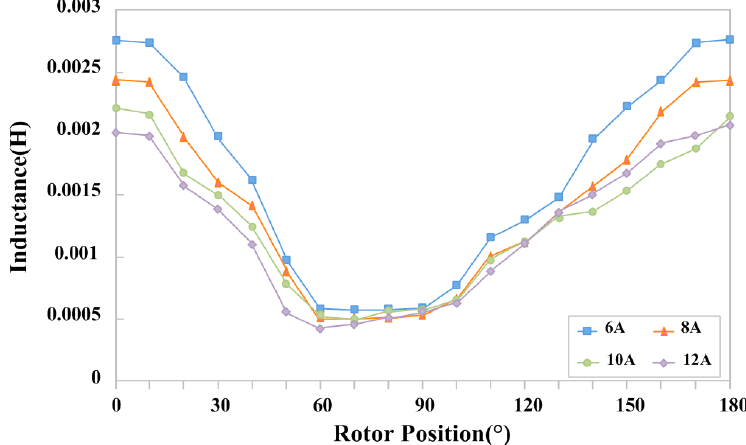
Figure 18. Measured inductance profiles.